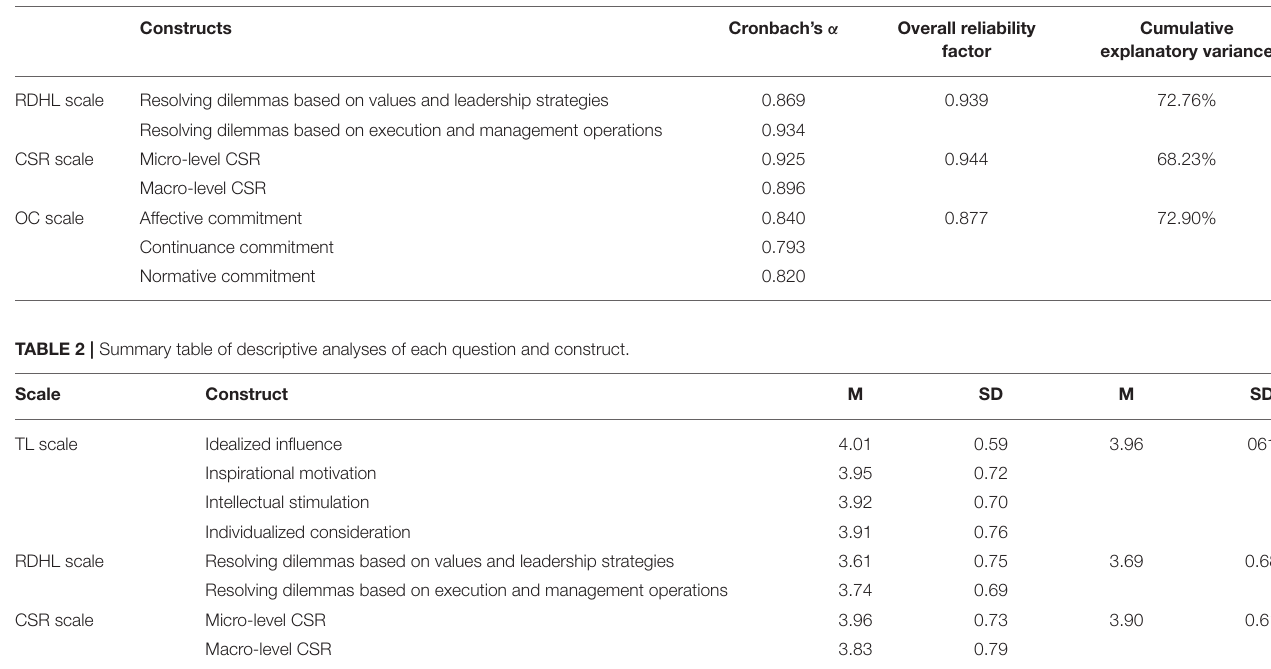
TABLE 1 | Summary table of factor and reliability analyses of the scales.